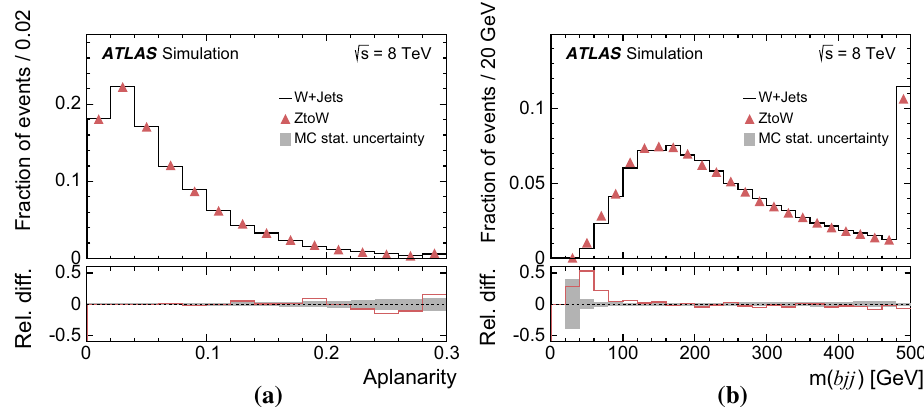
Fig. 1 Probability densities of a the aplanarity and b the mass distri- bution of the hadronically decaying top-quark candidates for simulated W +jets events with at least four jets and at least one b -tag and Z to W events derived from a simulated Z +jets sample with at least four jets and no b -tagging requirement. The lower histogram shows the relative